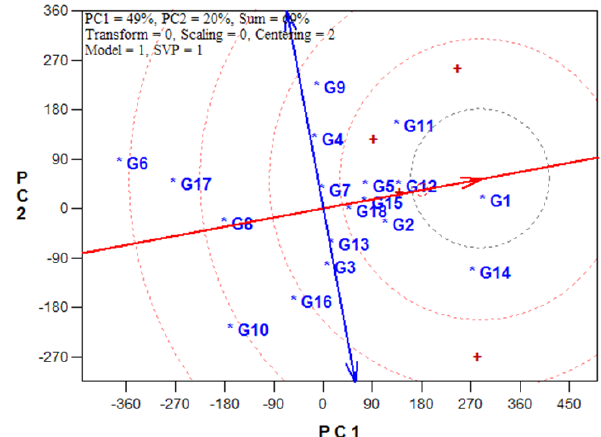
Fig. 4. Vector view of GGE biplot for relationships among geno- types